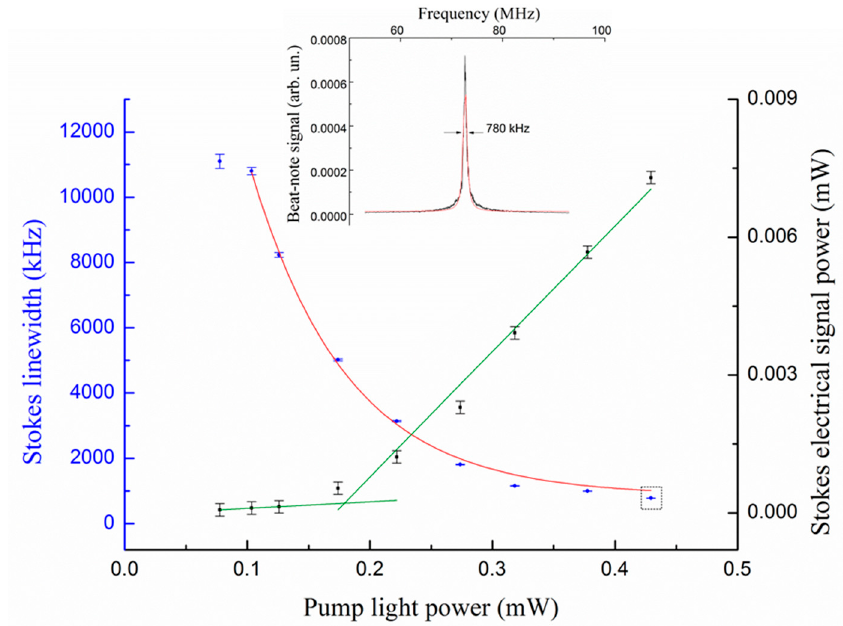
Figure 14. Stokes linewidth and power vs. pump light power injected into the droplet. The Stokes beat-note power (black squares) increases with pump and exhibits a knee with slope change at a threshold ~180 µ W. The narrowest observed lineshape is shown in the inset with a red line representing a Lorentzian fit (All plots are reproduced with permission from [61]).